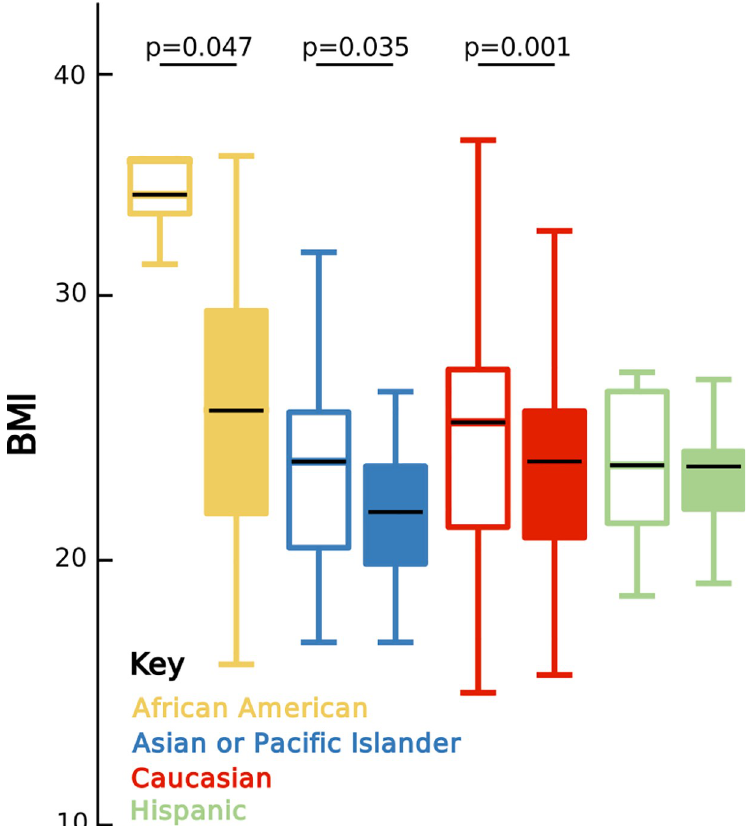
Fig 5. Christensenellaceae variably associate with BMI across ethnicities. Boxplots of BMI for individuals without (unfilled boxplots) and with (filled boxplots) Christensenellaceae. Significance was determined using one-tailed Mann– Whitney U tests for lower continuous BMI values. Black lines indicate the mean relative abundance; the lower and upper end of each box represent the 25 th and 75 th percentiles, respectively; and whiskers denote the 1.5 interquartile range. Data available at https://github.com/awbrooks19/microbiota_and_ethnicity. BMI, body mass index.